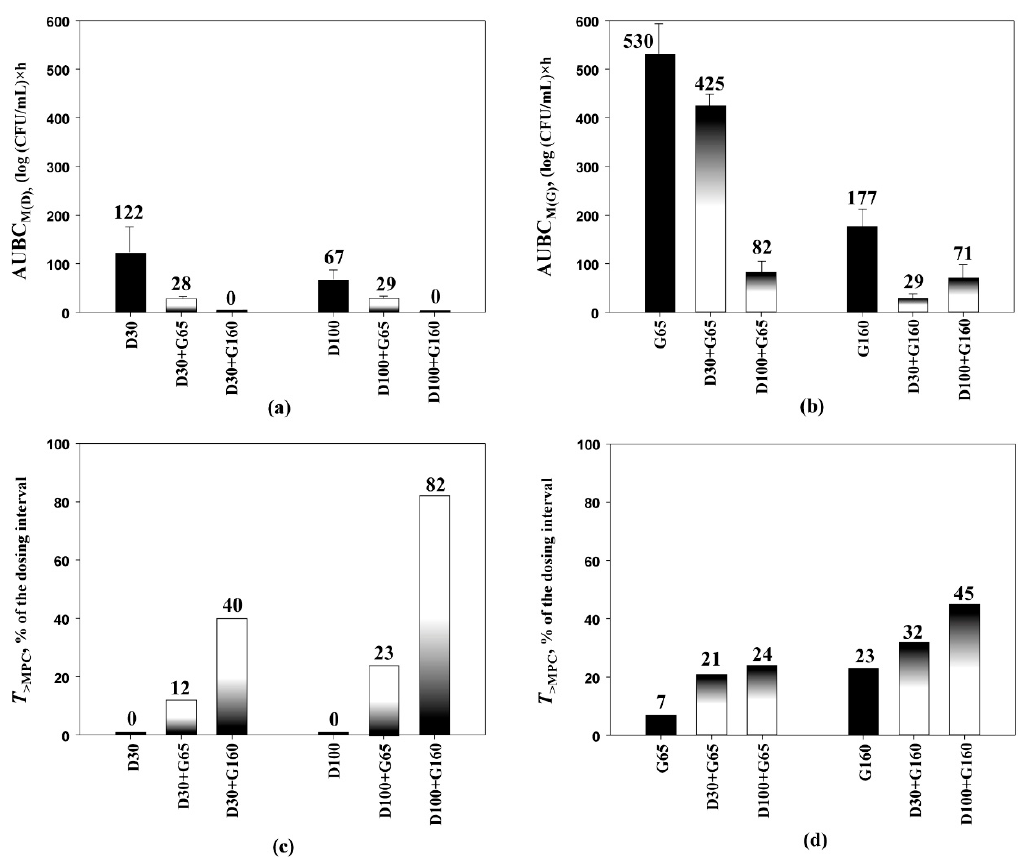
Figure 3. The enrichment of S. aureus 293 mutants resistant to 2 × MIC of daptomycin ( a ) or gentamicin ( b ) expressed as AUBC M, and the respective values of T >MPC ( c , d ). The parameter values are indicated over each bar. AUBC M data are presented as arithmetic means ± standard deviations.